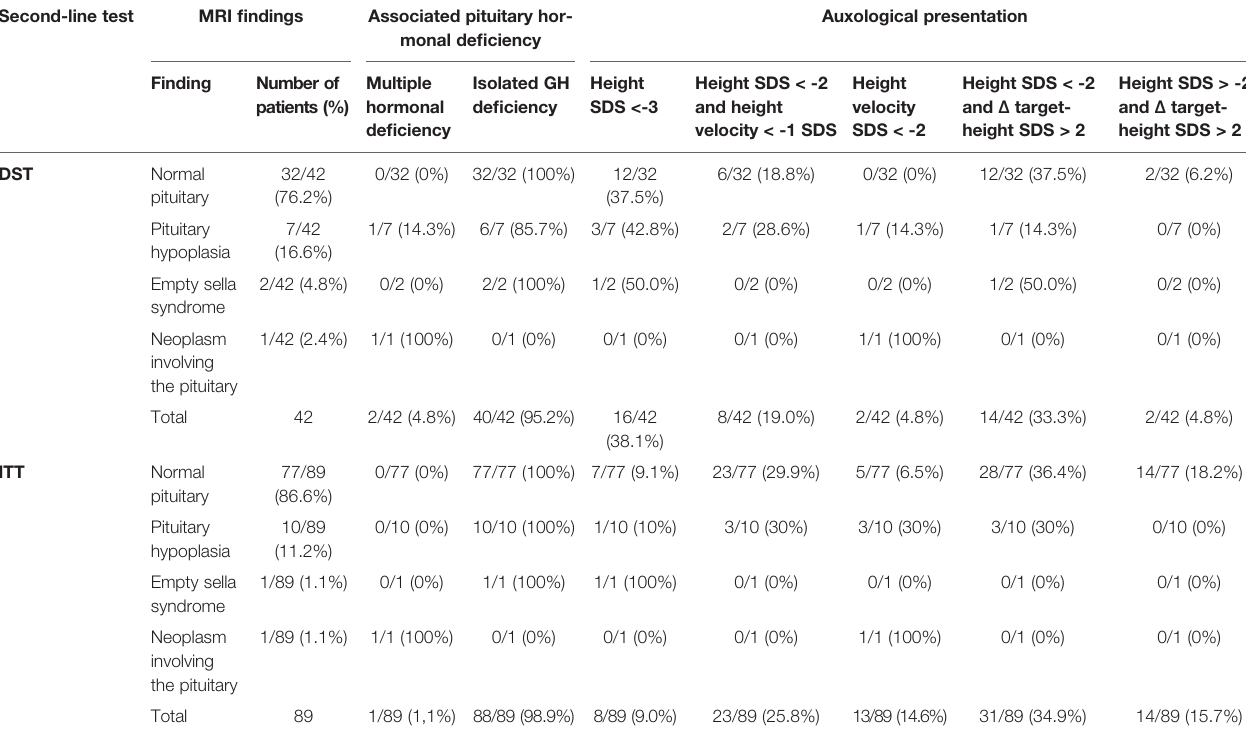
TABLE 3 | Radiological fi ndings, pituitary hormonal pro fi le and auxological features of the 131 patients diagnosed with GH de fi ciency within the study population. Second-line